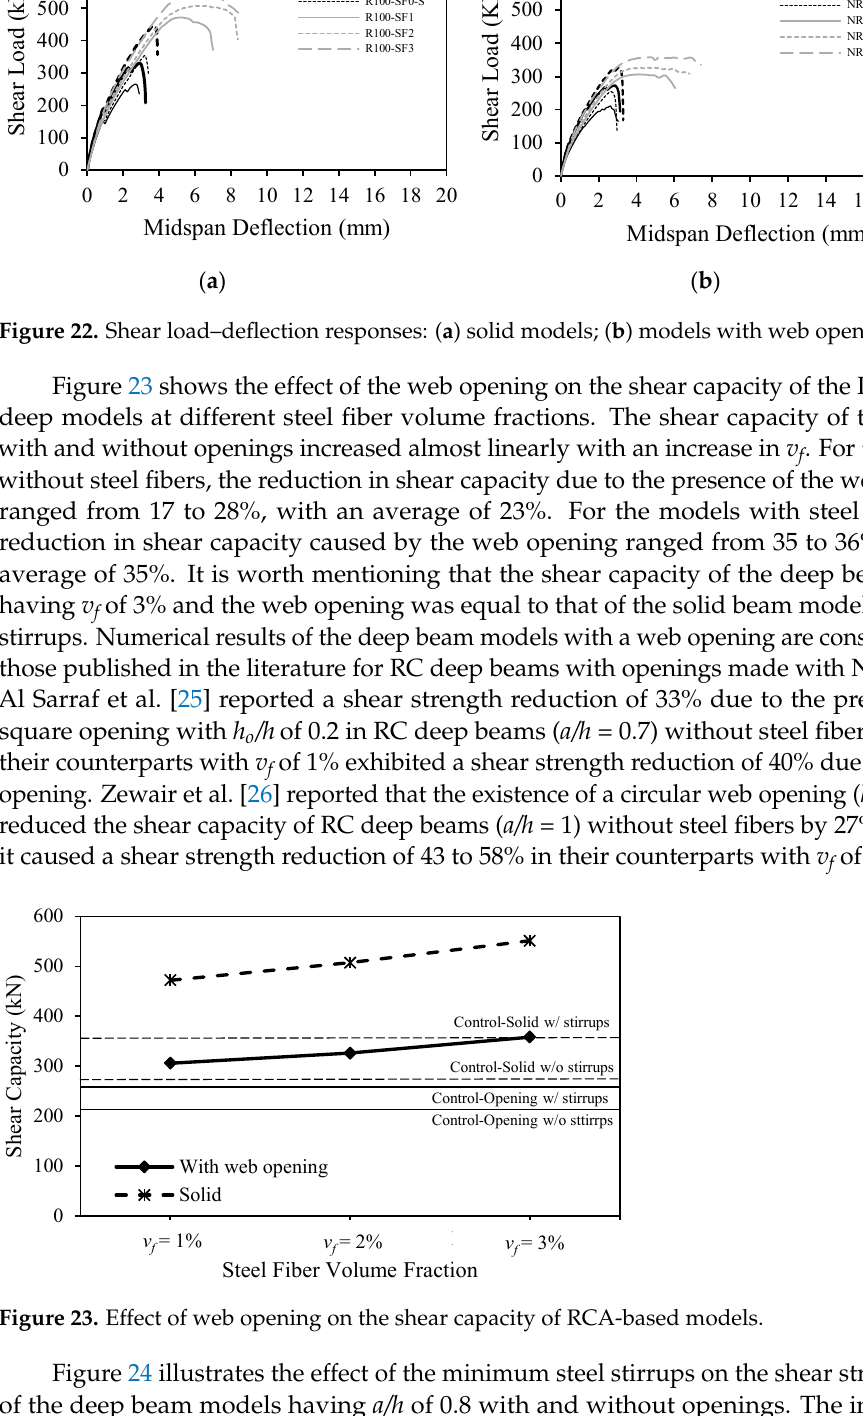
Figure 23. Effect of web opening on the shear capacity of RCA-based